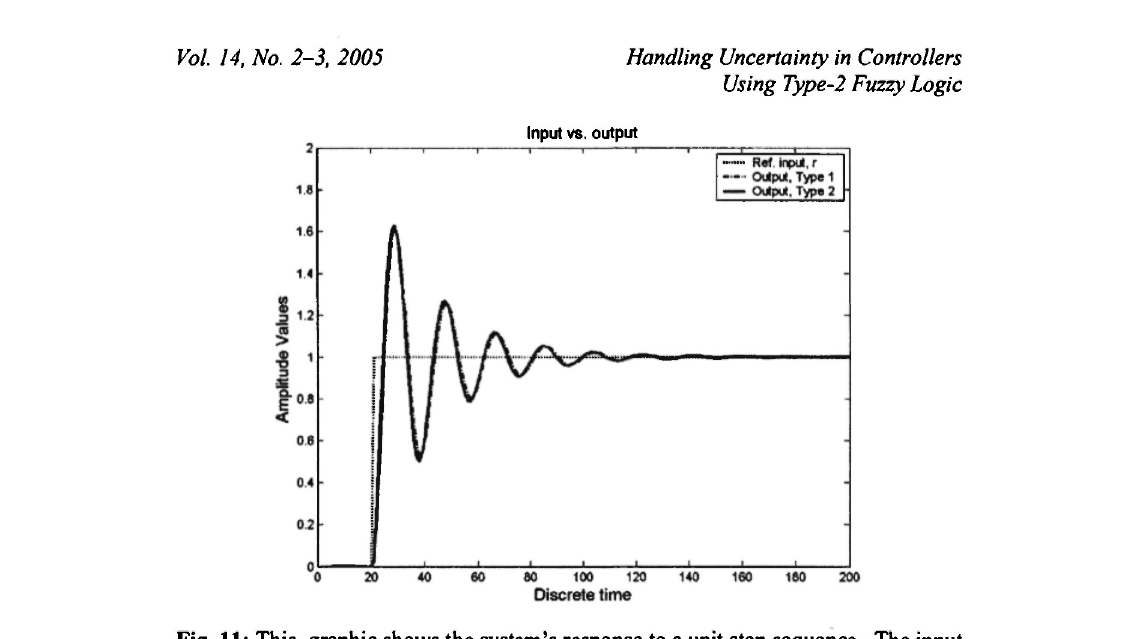
Fig. 11: This graphic shows the system's response to a unit step sequence. The input reference r is shown with pointed line. For type-1 the system's output yii) is shown with dash-dot line; and for type-2, the system's output y(i) with continuous line. Note, that both responses are very similar, although, in this case the lower errors were obtained with a type-1 FLC.